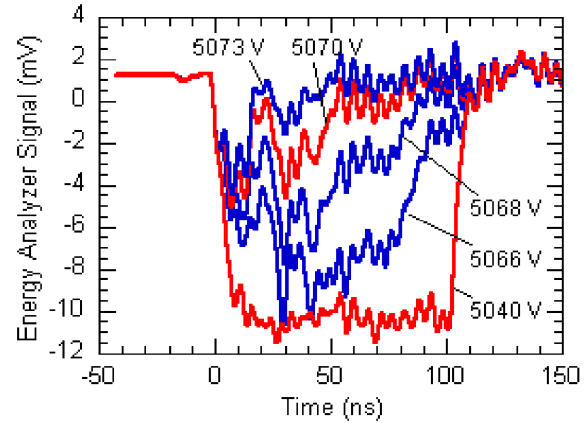
keV.FIG. 7. (Color) Energy analyzer outputs at different retarding